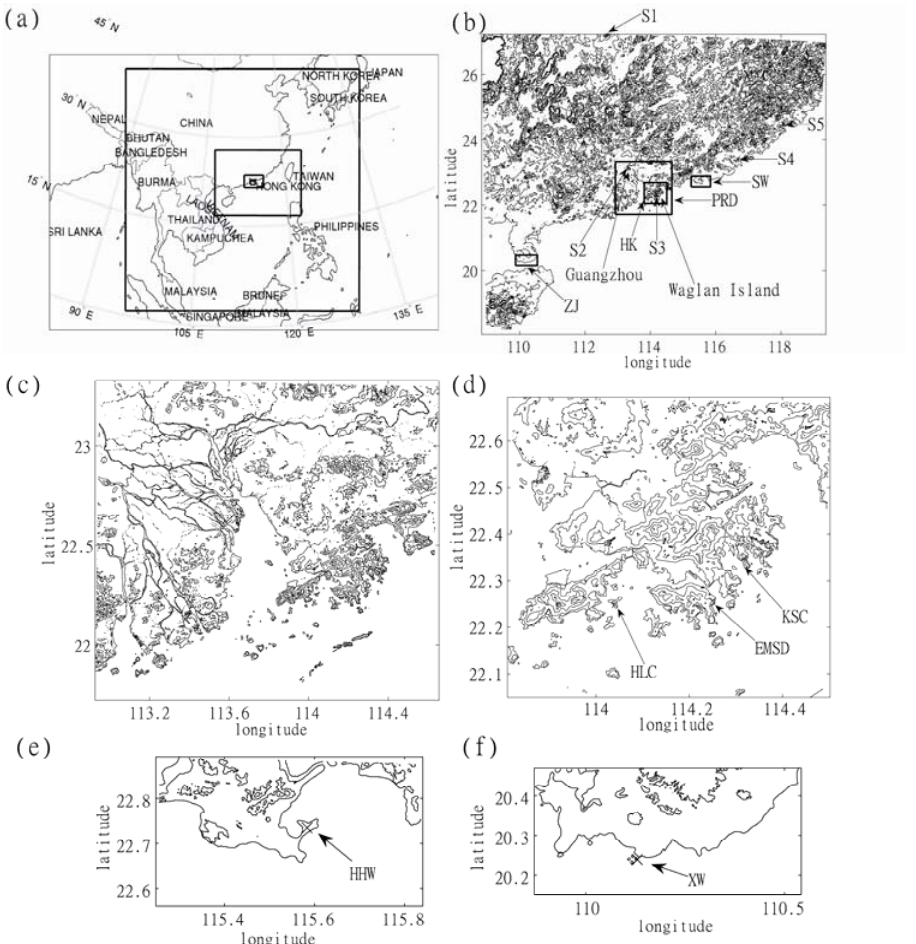
Figure 2. (a) Four nested domains used in MM5 (solid lines); resolutions from outer-most to innermost domains are 40.5, 13.5, 4.5 and 1.5 km. (b) Computational domain of GD in CALMET and shaded contours representing complex topography. Black boxes in (b) shows computational domains of (c) PRD, (d) HK, (e) Zhan Jiang (ZJ) and (f) Shan Wei (SW). The contour lines levels (in metres) are 0, 100, 300, 500, 700 and